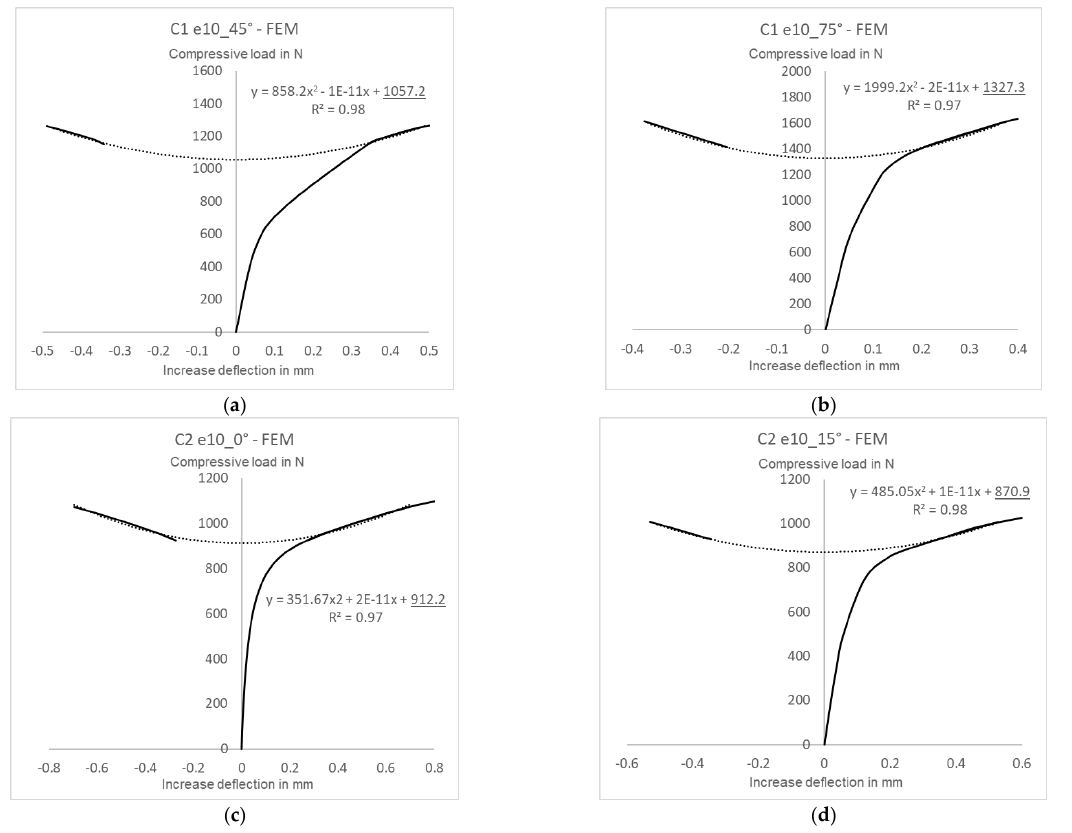
Figure 13. Numerical critical loads for structures with initial imperfections: ( a ) C1 e10_45 ◦ , ( b ) C1 e10_75 ◦ , ( c ) C2 e10_0 ◦ , ( d ) C2 e10_15 ◦ .